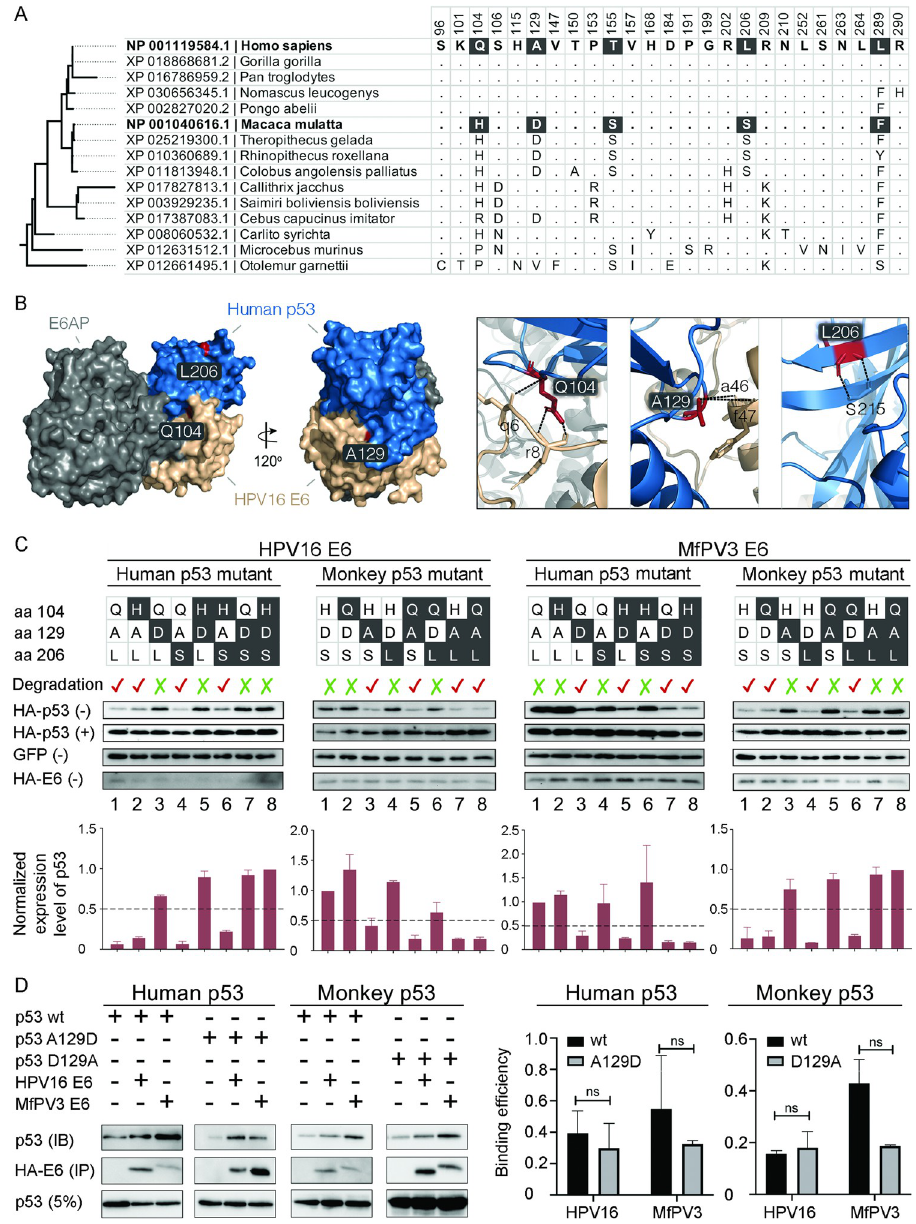
Fig 3. p53 residue 129 for host species-specific E6-mediated degradation. (A) Amino acid alignment of the E6-binding domain (aa 94–292) of p53 in major primate hosts identified five distinguishing residues (104Q/H, 129A/ D, 155T/S, 206L/S, and 289L/F) between Homo sapiens and Macaca mulatta . (B) Estimated structures of the HPV16 E6, human p53 and E6AP complexes. Surface representation of the p53, E6 and E6AP domains are colored in blue, tan and grey, respectively. Three indicated p53 residues (Gln104, Ala129 and Leu206) are denoted in red. Views of sub- interfaces of these three mutations are shown in the boxes on the right panel of the figure. Direct polar interactions are presented with dashed lines. Residues of p53 and E6 are indicated in upper- and lower-case, respectively. (C) Degradation of human and monkey p53 mutants mediated by HPV16 and MfPV3 E6s in C33A cells. Bar charts below the western blot images show the normalized expression levels of p53 against GFP. (+) and (-) indicates treatment with and without proteasome inhibitor MG132, respectively. The expression levels of GFP and HA-tagged E6 treated with MG132 are shown in S2 and S3 Figs. (D) Co-immunoprecipitation of HA-E6 and HA-p53 in H1299 cells indicates that residue 129 of the p53 mutants appeared to have no impact on the binding activity to the E6/p53 complex compared to the wild-type. IB: immunoblotting IP: immunoprecipitation; 5%: 5% loading of supernatant before IP. The bar charts on the right panel of the figure show the mean ( ± SEM) values of the binding efficiency inferred in triplicate samples. No statistical significance (ns, Student’s t- test) was observed between the wild-type and mutant